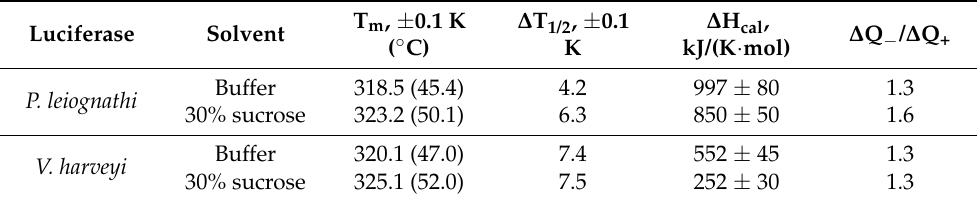
Table 2. The thermodynamic parameters of the thermal denaturation of the bacterial luciferases *. Luciferase Solvent